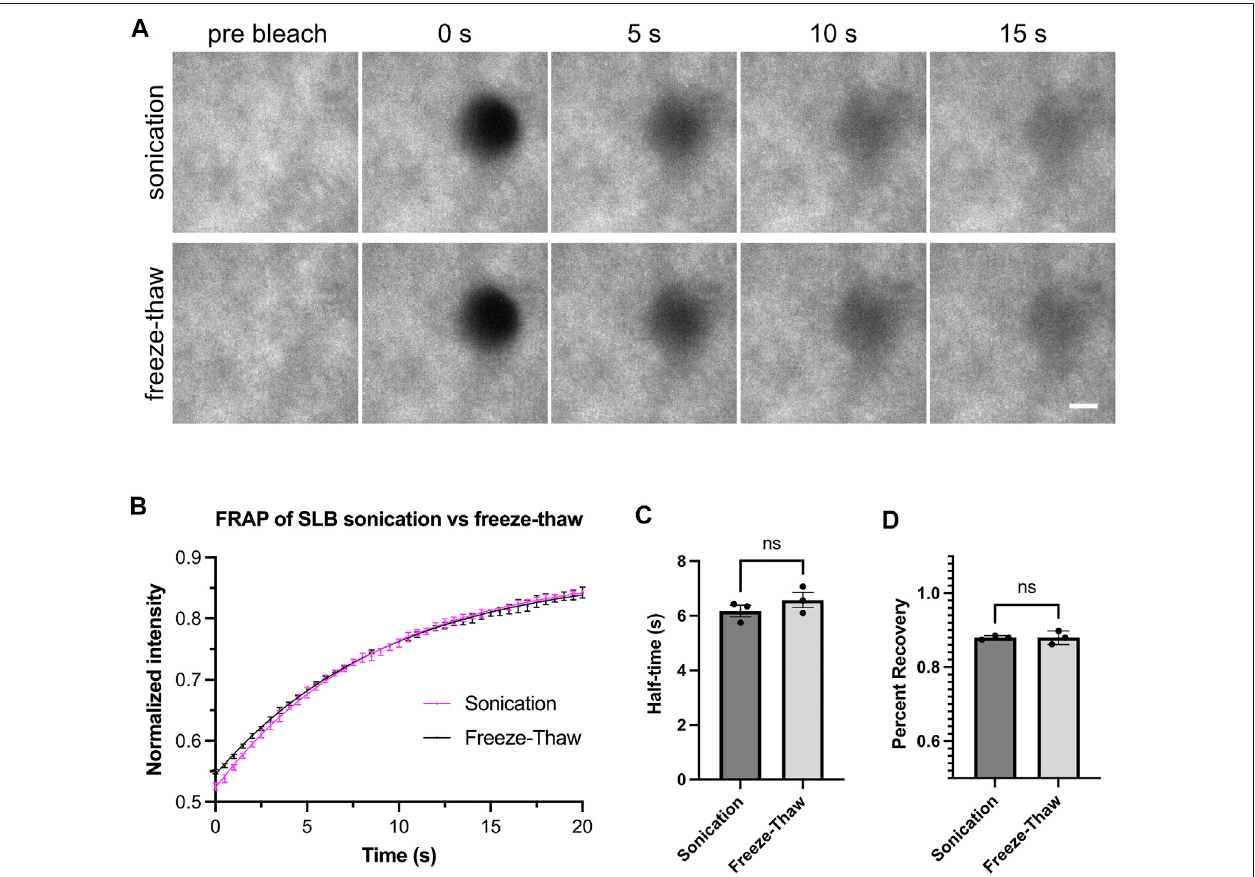
FIGURE2 | Freeze-thawand sonication methodsgenerate fl uid lipid bilayers. (A) Example images showing fl uorescence recovery after photobleaching (FRAP) for lipidbilayerslabeledbyHis 8 -nephrin(15%Alexa405labeled).BilayersimagedwithTotalInternalRe fl ectionFluorescence(TIRF)microscopy.Thesebilayerscontain98% POPC, 2% Ni-NTA, and 0.01% PEG5000-PE. Scale bar, 5 µm. (B) FRAP measurement of bilayer. Each point represents the mean ± standard deviation of three independent measurements. A curve calculated from a single exponential fi t is overlaid in the graph. (C,D) Recovery half time and percentage recovery calculated from the single exponential fi t for each measurement. Statistical analysis is carried out through unpaired student t -test with signi fi cance at p < 0.05.